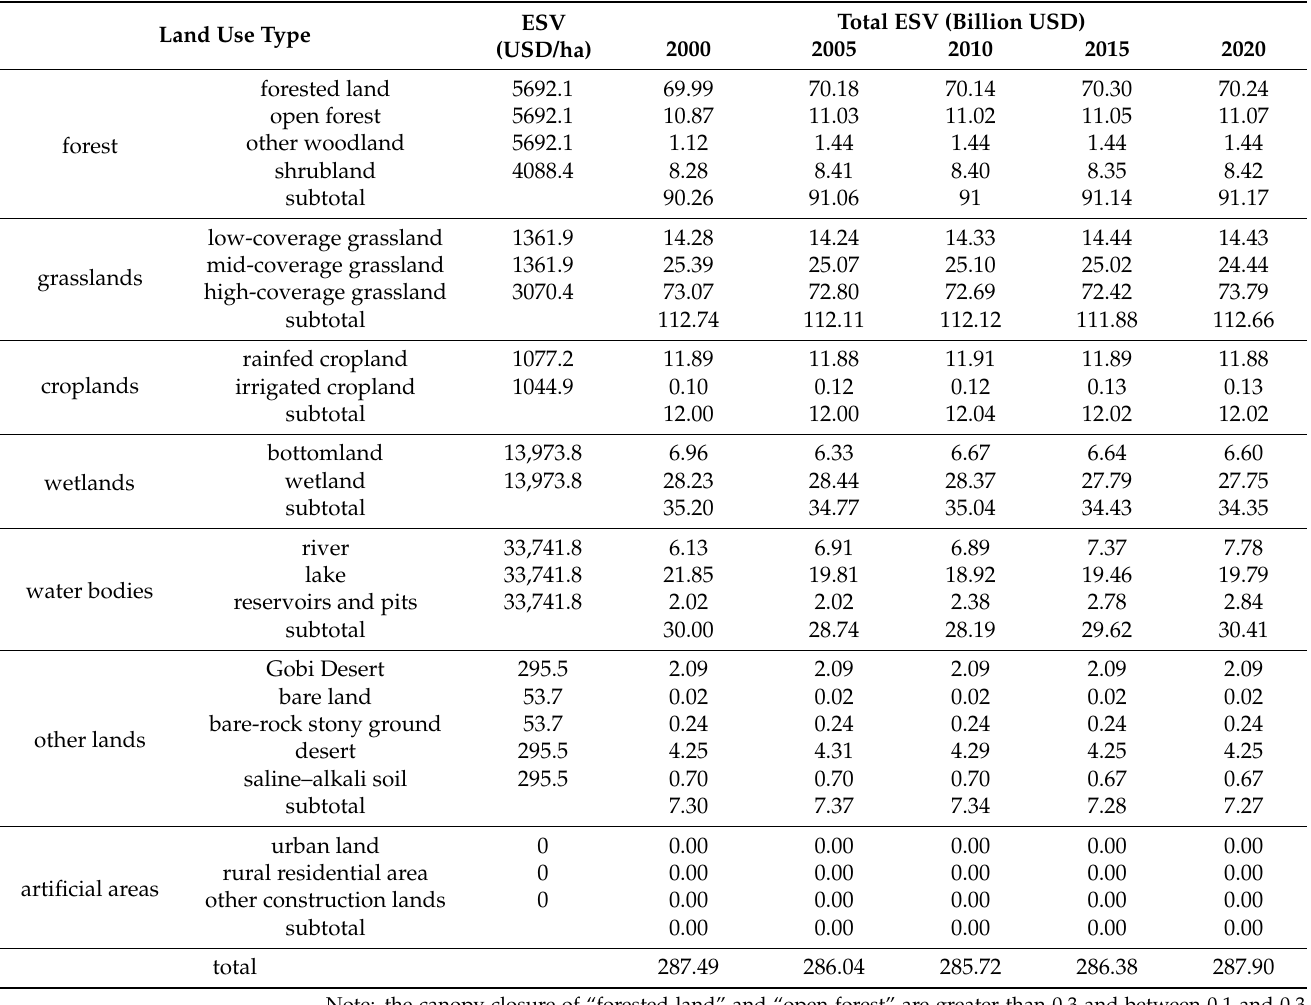
Table 2. ESV of different land use types in Inner Mongolia over time.